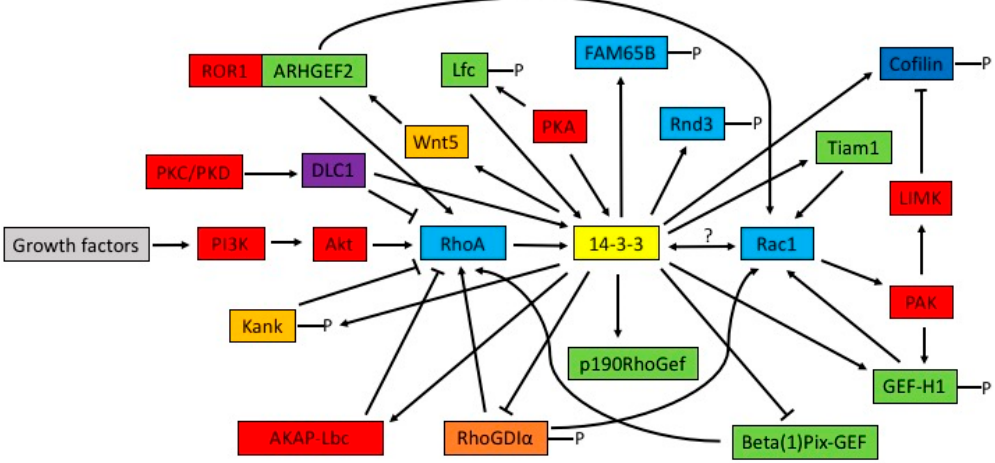
Figure 2. Reported interactions between 14-3-3 proteins and Rho GTPases. The 14-3-3 proteins interact indirectly or directly with many Rho regulators, eventually affecting multiple functions of the Rho GTPases including cytoskeletal remodeling and cell migration. Arrows represent activation and T-bars represent inhibition.